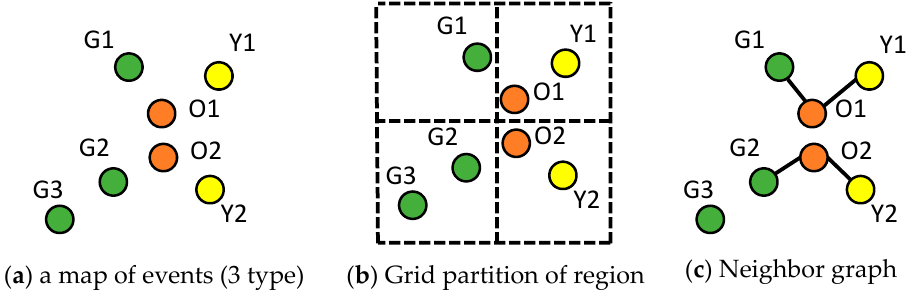
Figure A1. Example of spatial statistics. ( a ) Shows distribution of three types of events colored in green, orange and yellow. ( b ) Shows a grid partition that splits original study area into four cells. ( c ) Shows a neighbor graph generated based on point distribution in ( a ).